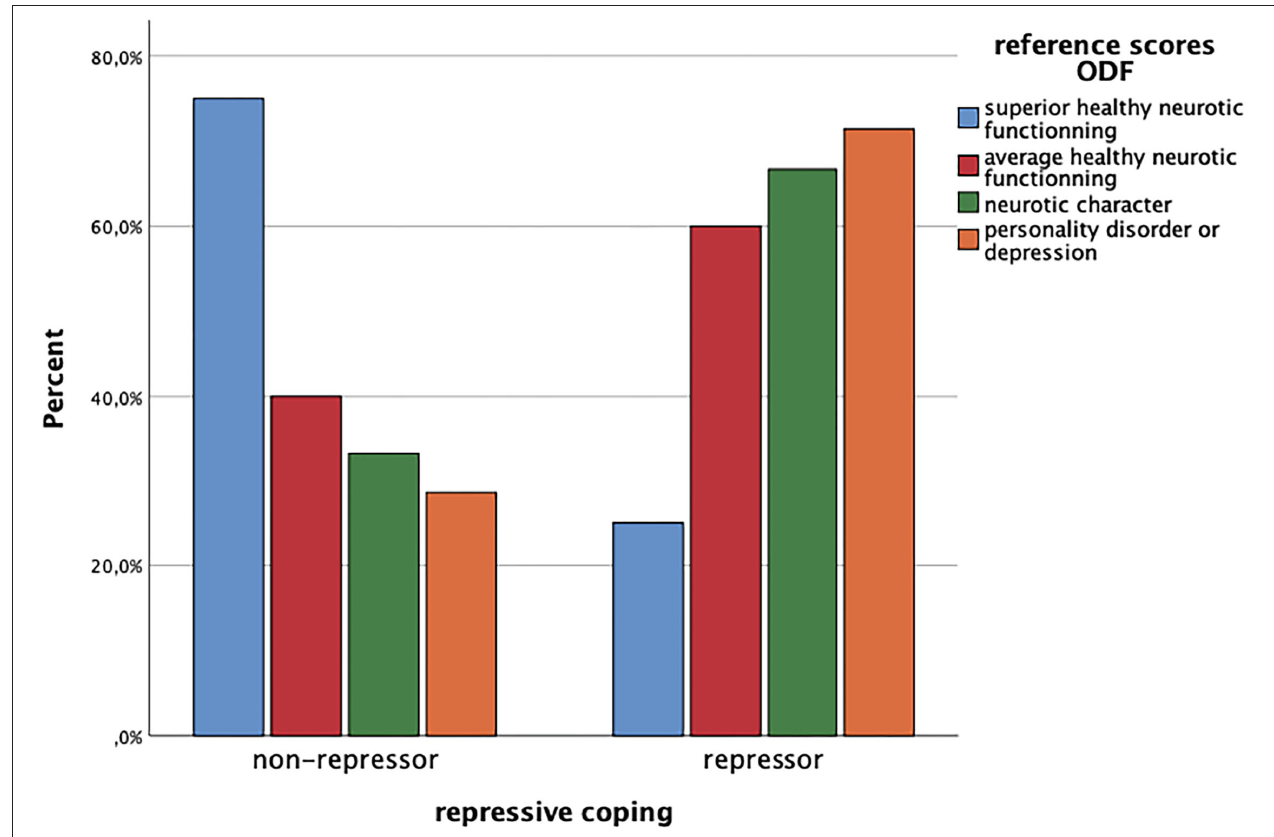
FIGURE 1 | Reference scores ODF and repressive coping. ODF, overall defensive functioning categories of the Defense Mechanism Rating Scales (DMRS); FoP-Q-SF, Fear of Progression; repressive coping = category derived from Marlowe-Crown Social Desirability Scale and State-Trait-Anxiety Scale (STAI-Trait).